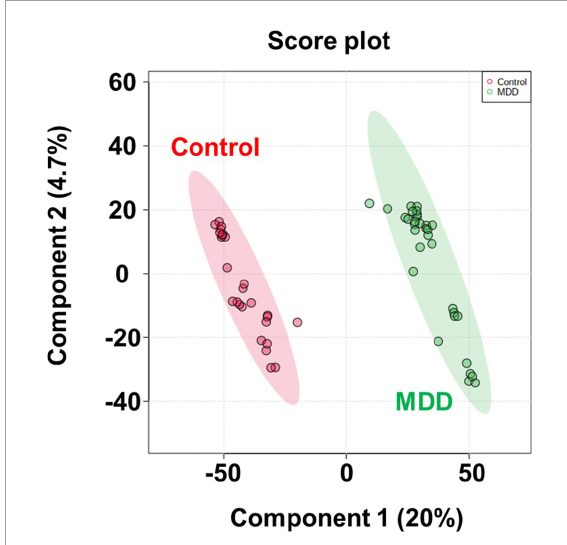
FIGURE3 PLS-DA score plot. PLS-DA analysis to confirm group difference between control and MDD. The red dot indicates the control group, and the green dot indicates the MDD group.